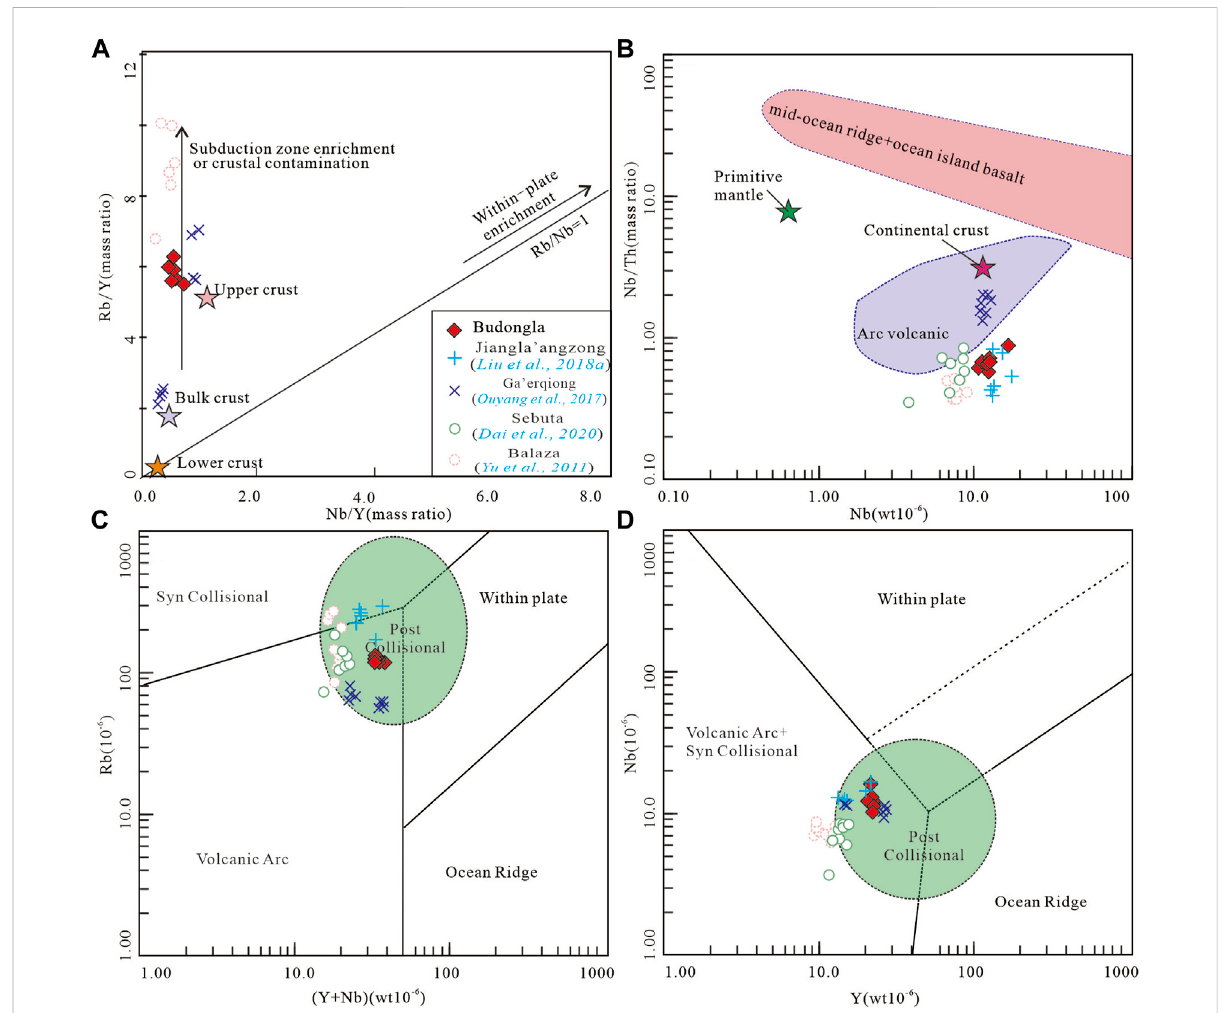
FIGURE 8 Tectonic discrimination diagrams. [ (A,B) , Basemap after Pearce et al., 1984; (C,D) , Basemap after Boztu ğ et al.,